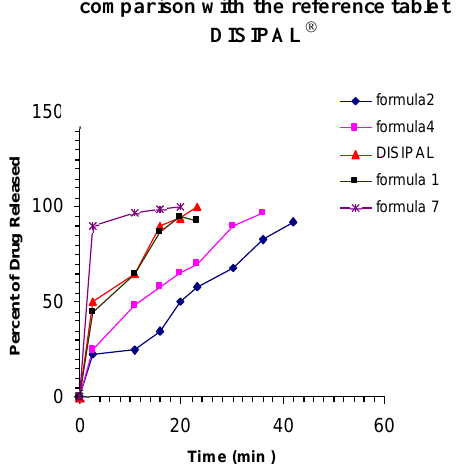
Fig. 2 : Effect of diluent on the release